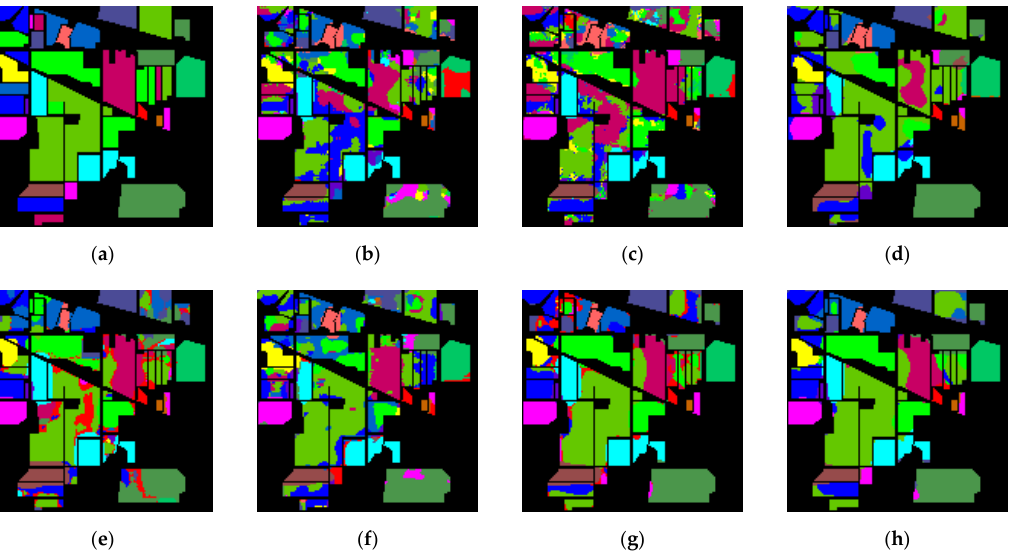
Figure 12. Classification maps for IP dataset. ( a ) Ground ‐ truth map; ( b ) 3D ‐ CNN; ( c ) HybridSN; ( d ) SSRN; ( e ) MCNN ‐ CP; ( f ) A 2 S 2 K ‐ ResNet; ( g ) Oct ‐ MCNN ‐ HS; ( h ) proposed method.